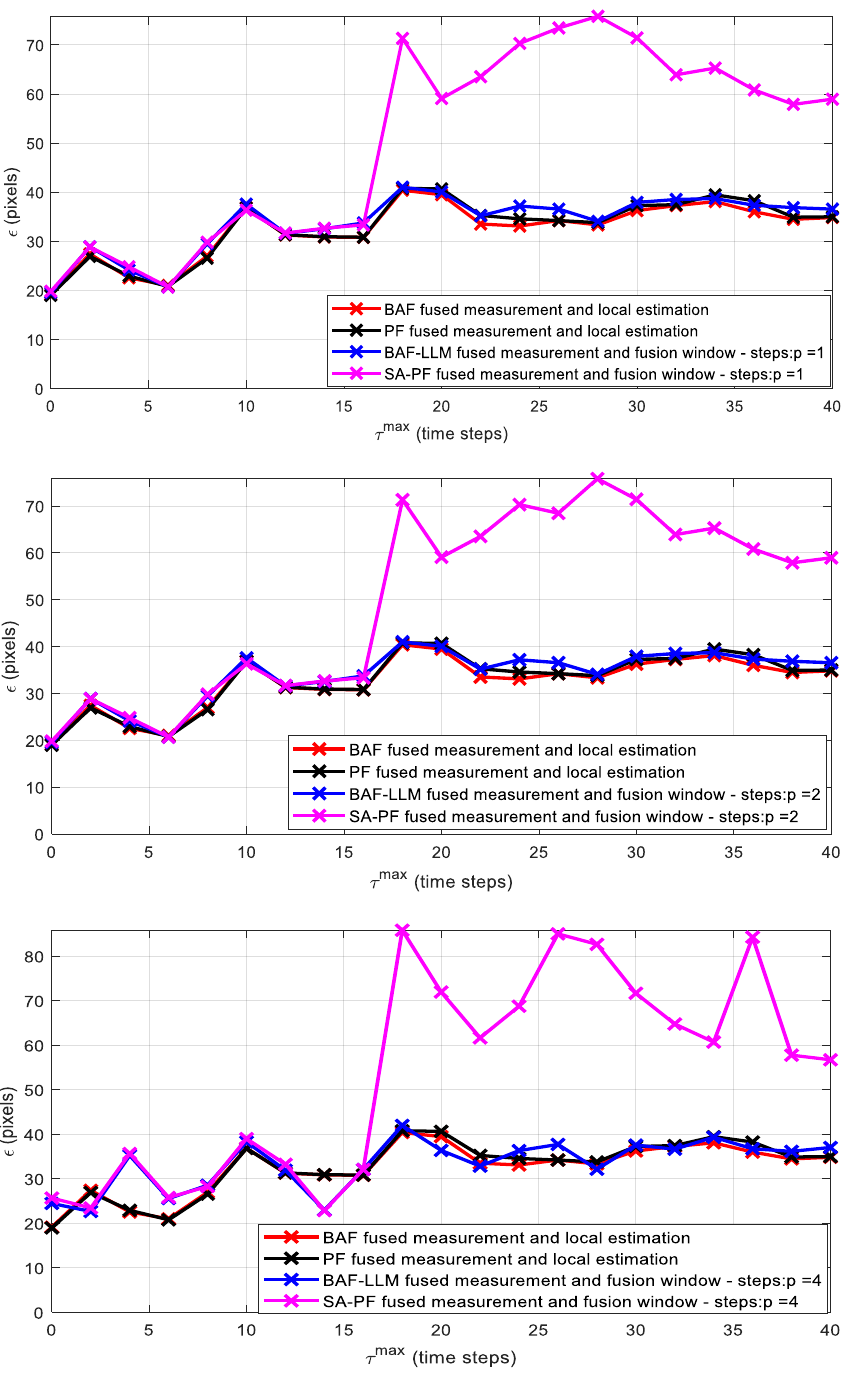
Figure 19. Performance with variation of α max and τ max with exchange of just LoS vectors for fused 3D position measurement followed by local estimation (strategy a) and exchange of additional content other than LoS vectors for further fusion (strategy b) in fusion window with duration p = {1,2,4} frames. The same process is applied to analyze the effect on ε of increasing 0 ≤ τ max ≤ 40 (see Figure 19) with a fixed processing delay τ max and relative offset α i at each i -th camera, and r -th run. Each camera has α i sampled once from U{ 0, α max } , (synchronous case) 0 ≤ α max ≤ 4 (asynchronous case) and remains the same throughout all